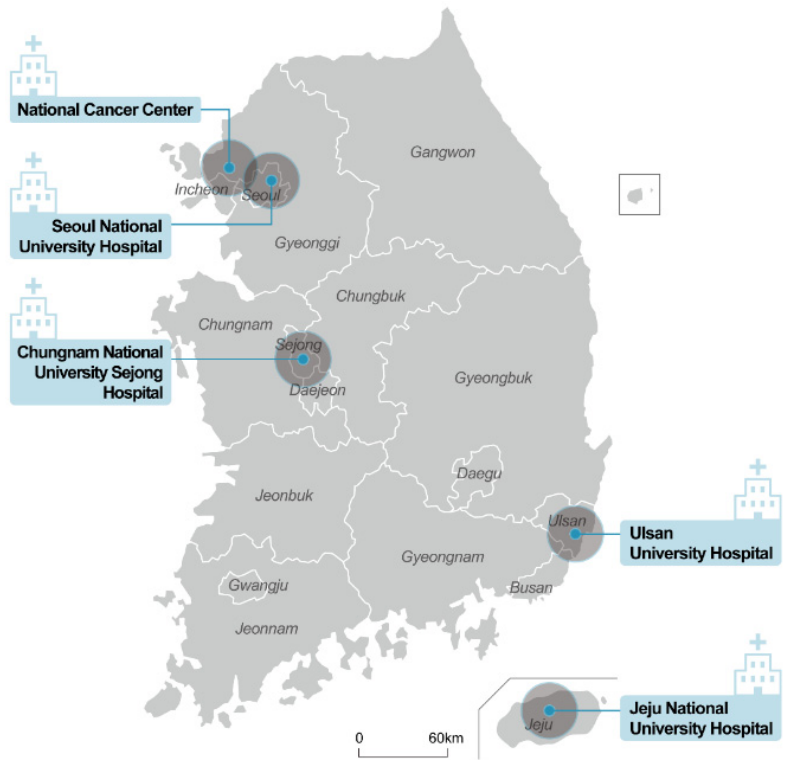
Figure 1. Geographic distribution of the five institutions participated in this study.